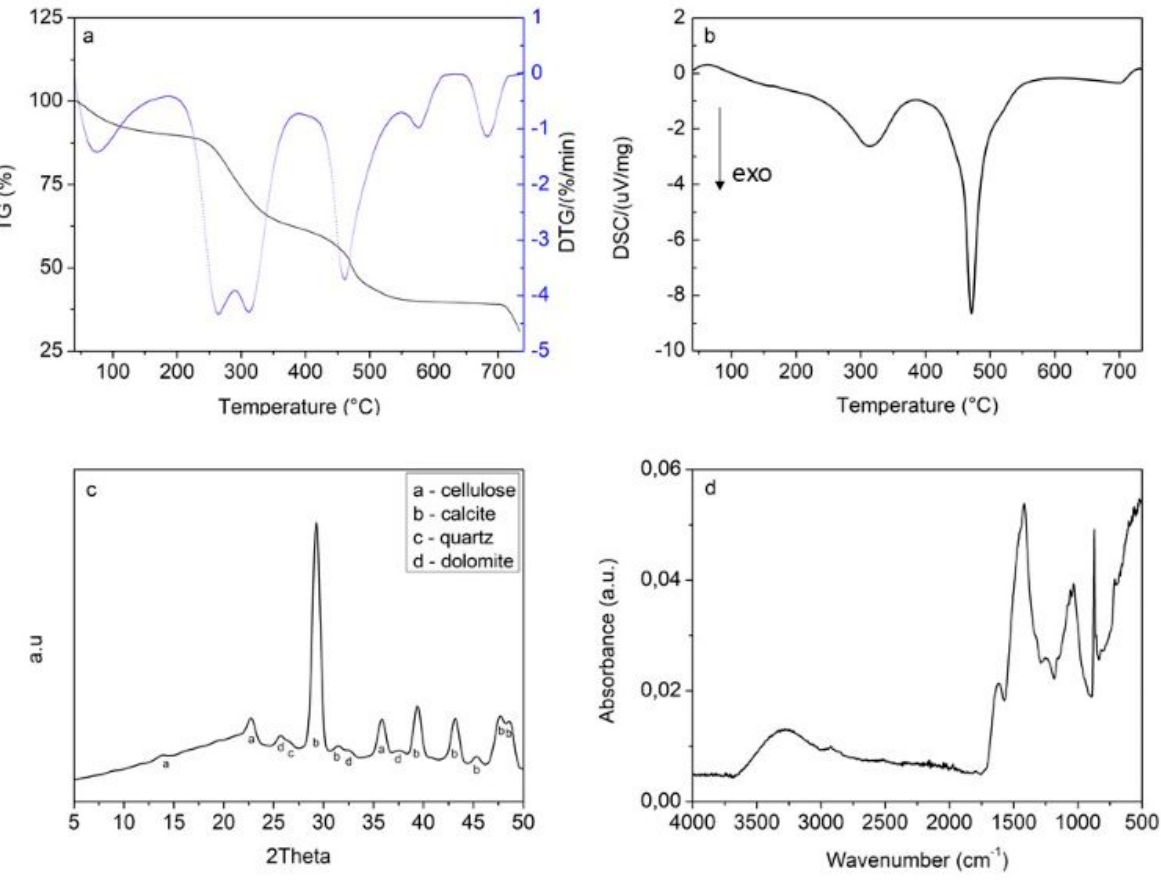
Figure 2. Characterization of Sargassum spp.: ( a ) TGA (%) and DTG (% · min − 1 ) curves, ( b ) DSC ( µ V · mg − 1 ) curve, ( c ) XRD patterns, ( d ) FT-IR spectra.